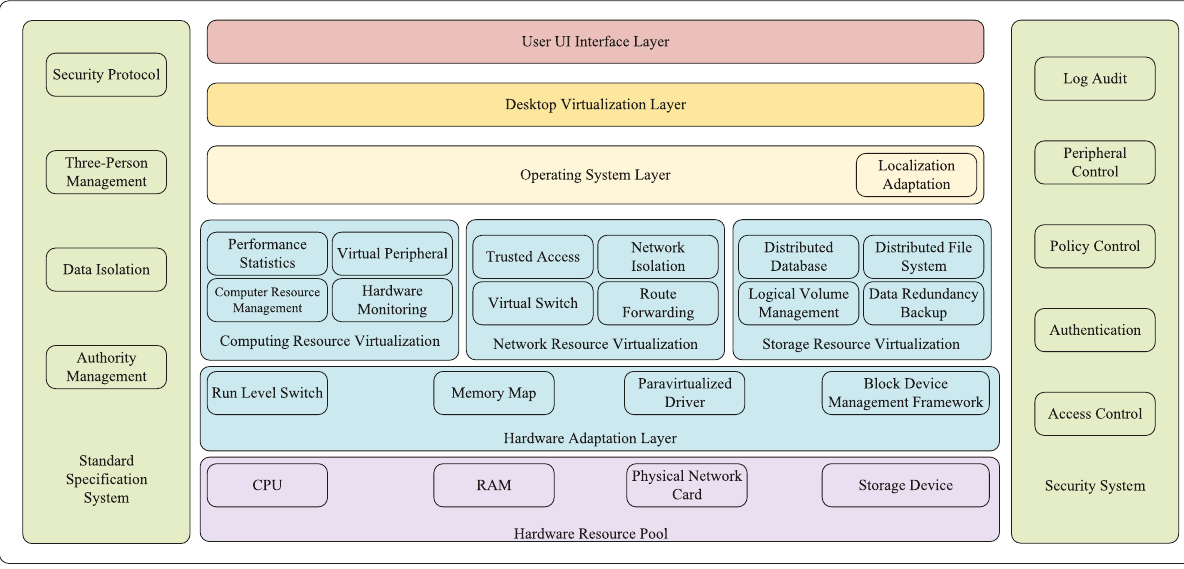
Figure 2: Space TT&C virtual platform basic architecture block